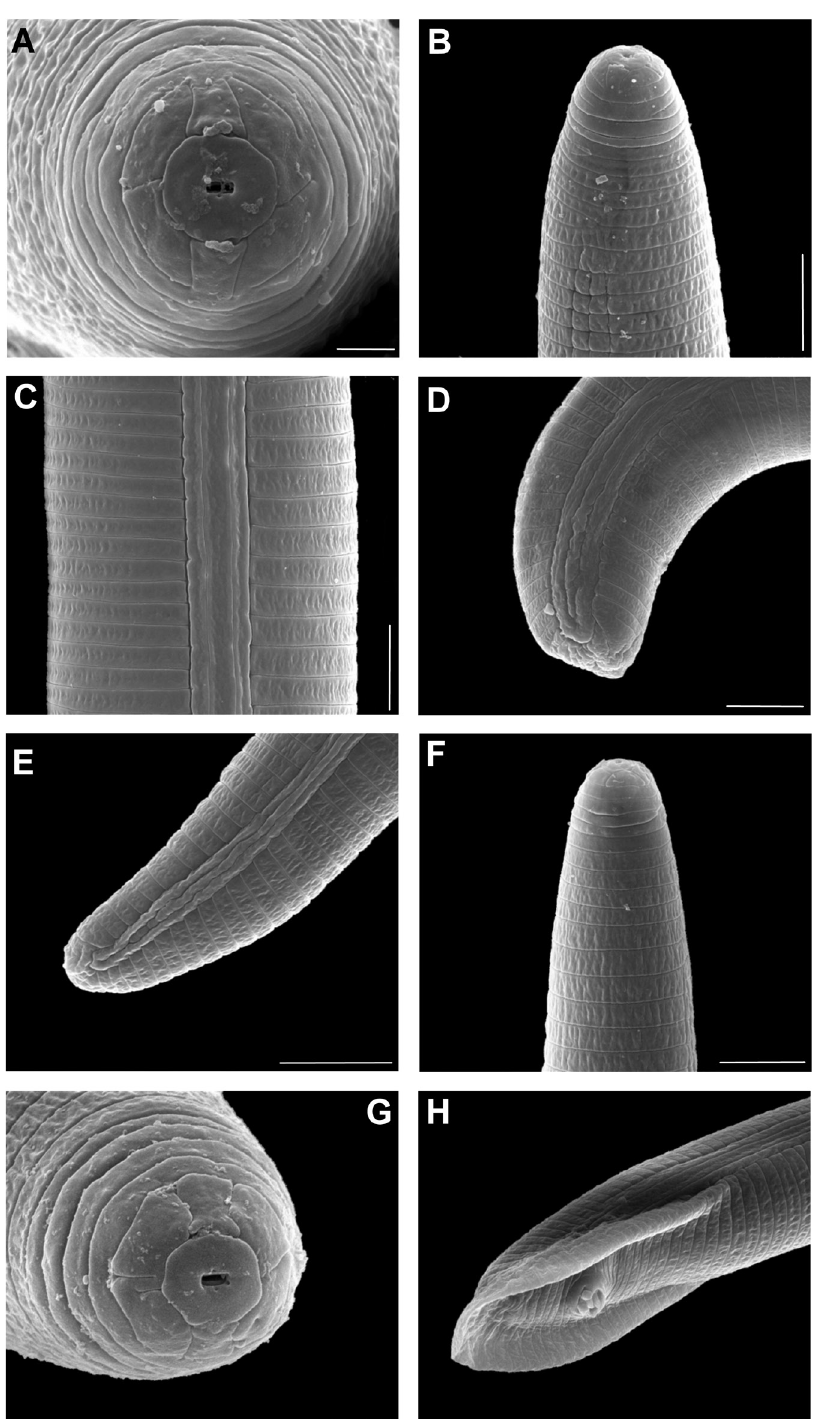
Figure 3. Helicotylenchus varicaudatus . Females (A–E). Lip region, face view (A), lip region, lateral view (B), lateral fields (C) and tails (D,E). Males (F–H). Lip region, lateral view (F), lip region, face view (G) and tail (H). Scale bars: A, G=1 µ m; B, C, D, E, F, H=5 µ